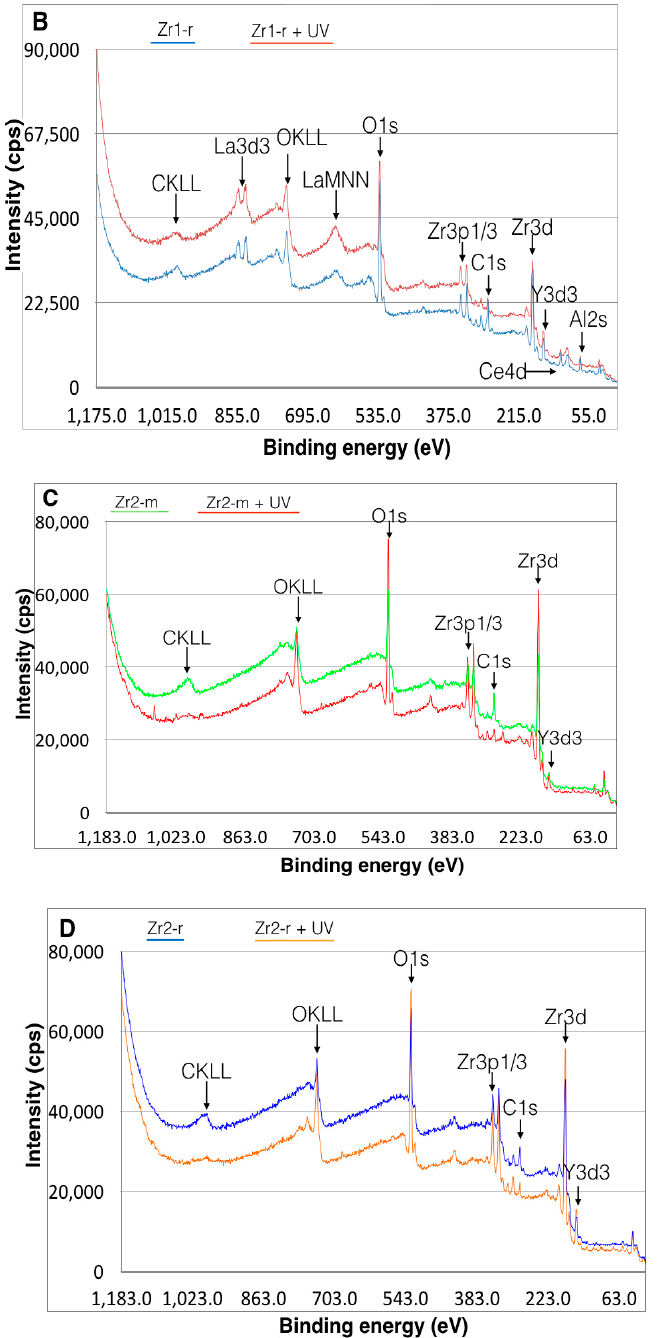
Figure 6. ( A – D ) X-ray photoelectron spectroscopy (XPS) spectrum for Zr1-m, Zr1-r, Zr2-m and Zr2-r surfaces before and after UV treatment.